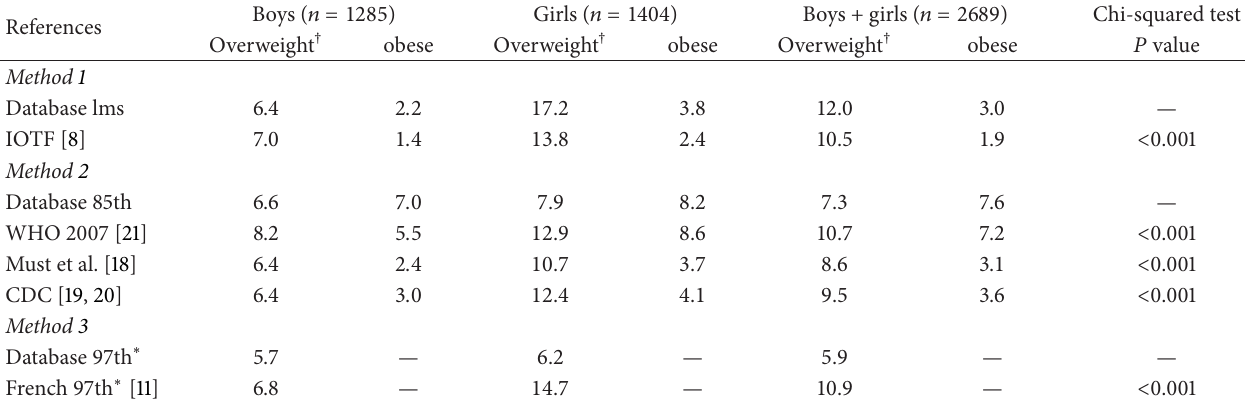
Table 5: Prevalence (%) of overweight and obesity in the study population according to different references.